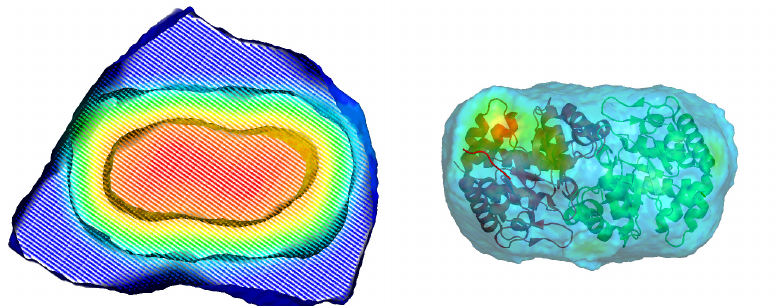
Figure 11. The calculated dimer core, ASU, and protein boundary of 2V30 in a successful run. The 2-fold NCS axis is perpendicular to the plane of the paper.